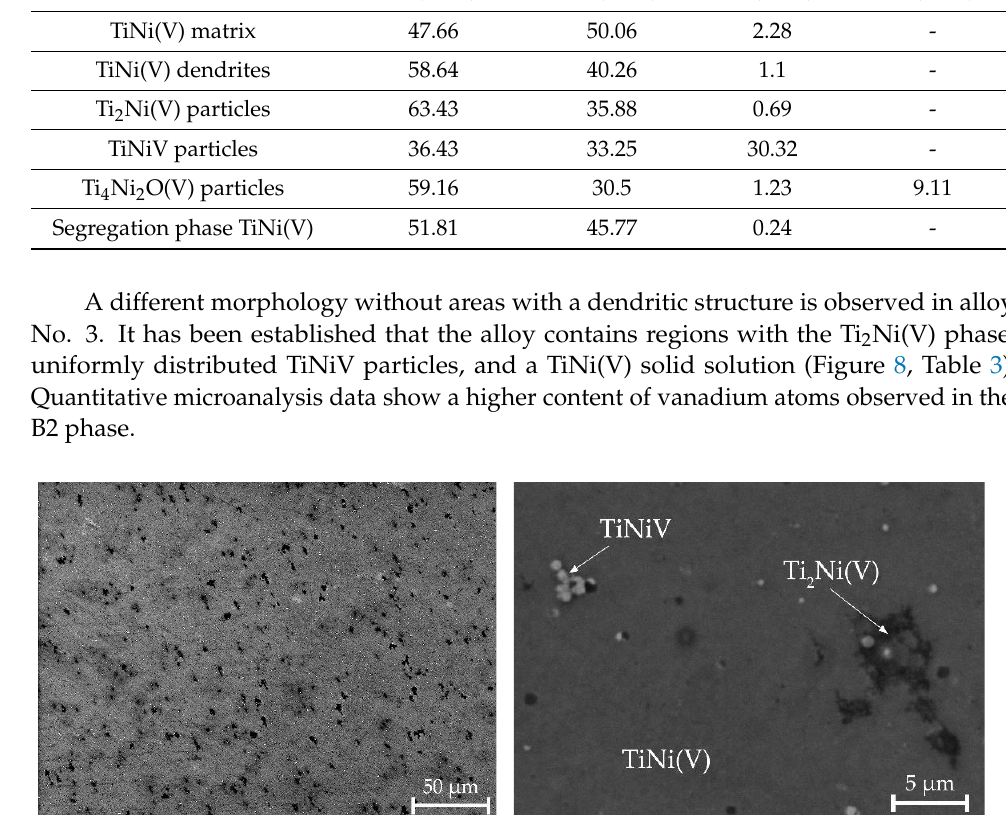
Table 2. Quantitative elemental composition of the structural components of alloy No. 2. Structural Component